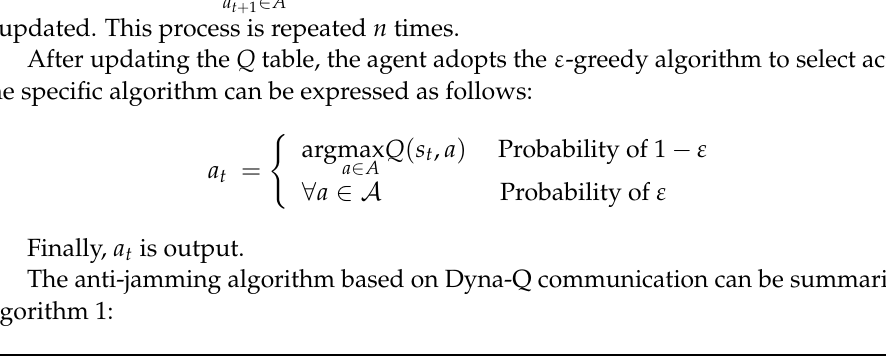
Algorithm 1. Anti-jamming algorithm for wireless communication network